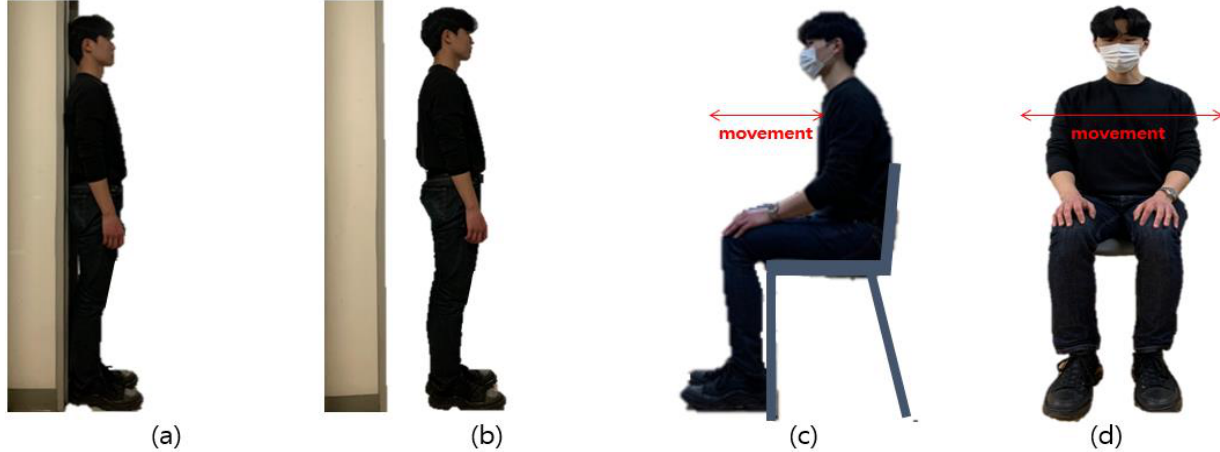
Figure 5. Subject’s postures and movements: ( a ) leaning against the wall; ( b ) without leaning against the wall; ( c ) moving forward and backward; ( d ) moving left and right.